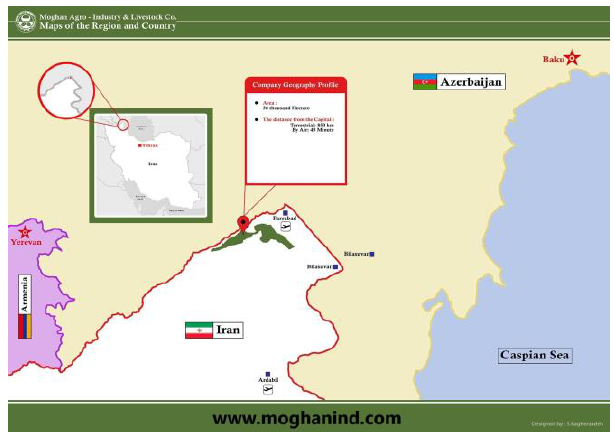
Figure 1. Location of the Moghan plain